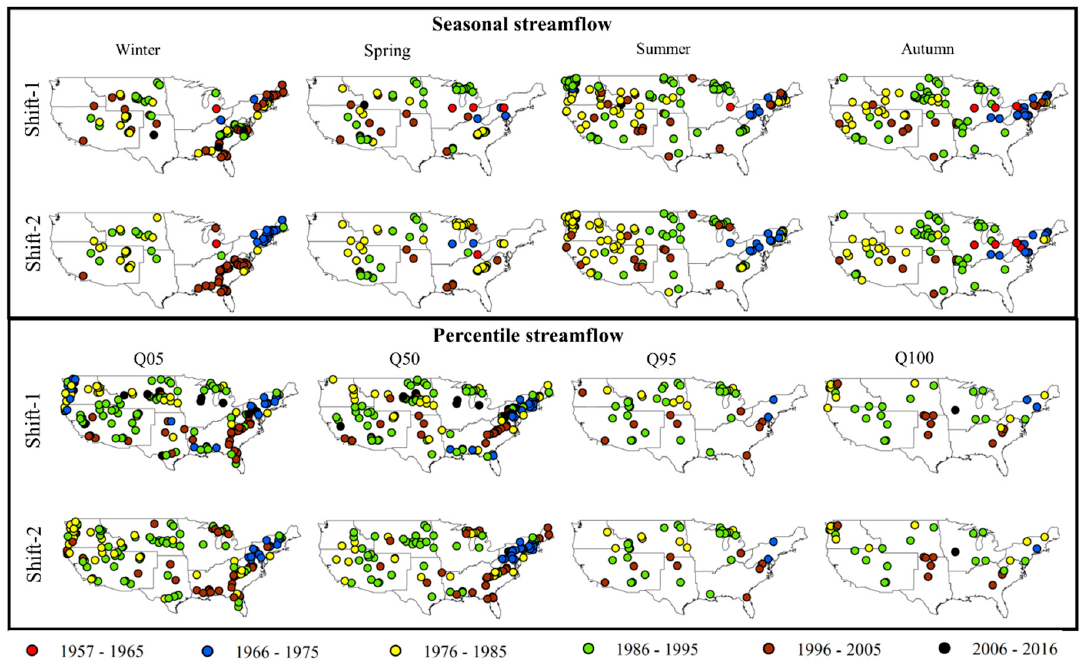
Figure 5. Maps showing change points for seasonal and percentile streamflow corresponding to both Shift-1 and Shift-2.